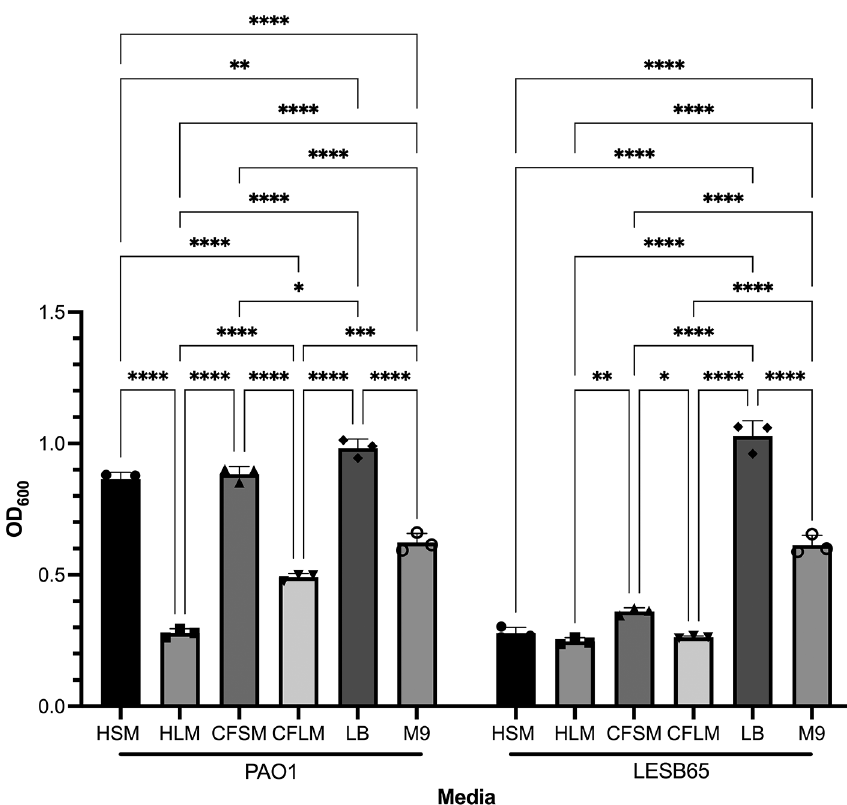
Figure 2. Attached biofilm biomass of PAO1 and LESB65 in respiratory-mimicking media, LB and M9. Bacteria were left to form biofilms for 72 hours. Unattached bacteria were removed and washed with PBS to ensure removal of all unattached bacteria. Attached bacteria stained with 0.25% CV and absorbances were measured by using 95-100%ethanolasblankcontrolatOD600.Statisticalanalysiswasundertaken